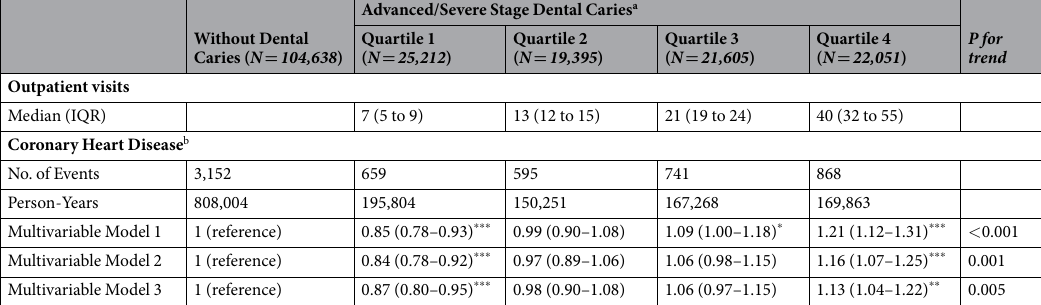
Table 2. Hazard ratios (and 95% confidence intervals) for coronary heart disease in patients with advanced/ severe stage dental caries as compared to those without dental caries in the National Health Insurance Service- Health Screening Cohort (NHIS-HEALS). a Includes ICD-10 codes for irreversible pulpitis (K04.0), necrosis of pulp (K04.1), and periapical abscess with sinus (K04.6) with at least 2 outpatient visits. b Includes ICD-10 codes for coronary heart disease (I20–I25). NOTE: Models represent multivariable Cox regression models. Model 1 adjusted for age, sex, insurance premium, residential area. Model 2 adjusted for variables included in Model 1 and year of diagnosis, physical activity, alcohol consumption, cigarette smoking, total cholesterol level, fasting serum glucose level, systolic blood pressure, body mass index. Model 3 adjusted for variable included in Model 2 and family history of heart disease, and Charlson Comorbidity Index. Abbreviation: IQR, interquartile range; HR, hazard ratio; CI, confidence intervals; ICD, international classification of diseases * p < 0.05, ** p < 0.01,